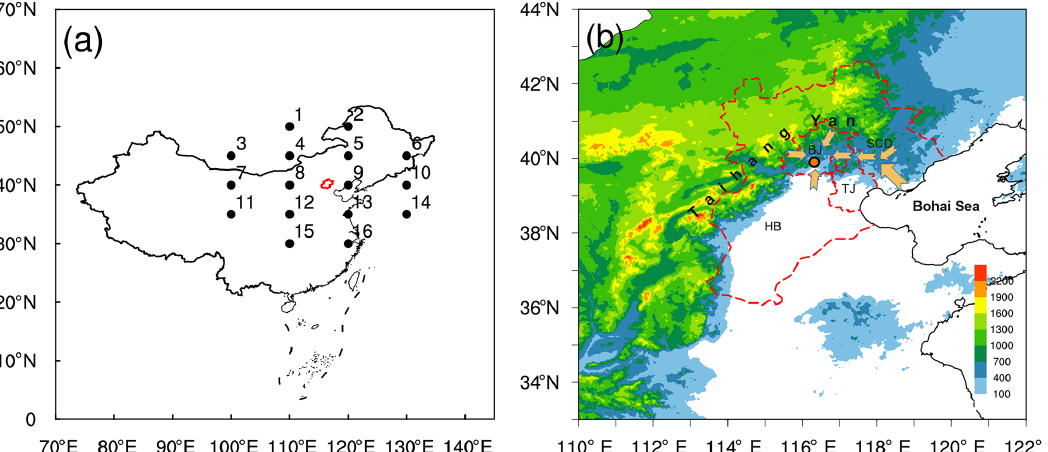
Figure 1. The locations of 16 grid data of the 5 ◦ × 10 ◦ MSLP used for Lamb–Jenkinson weather type classification (black dots) (a) . The terrain height of the North China Plain (shaded; units: m) (b) . The location of Beijing city and the Beijing–Tianjin–Hebei region is marked by the solid red lines and dashed red lines, respectively. The orange dot indicates the location of remote-sensing devices. The arrows indicate the horizontal-coupling mechanism of how multiscale circulations affect pollution by generating convergent